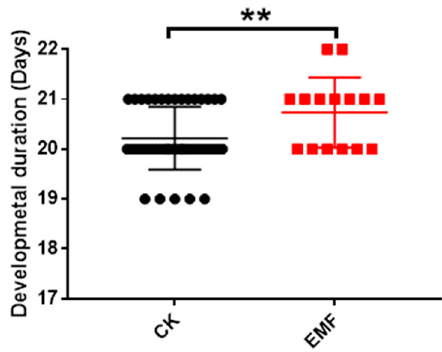
Figure 3. Effect of ELF-EMF exposure on the development duration of honeybee larvae. EMF: ELF- EMF exposed group (Red square). CK: Control group (Black dot); ELF-EMF exposure significantly increased the developmental time of honeybee larvae ( t -test, t = 2.747, df = 61, p = 0.0079). Note: ** means p <